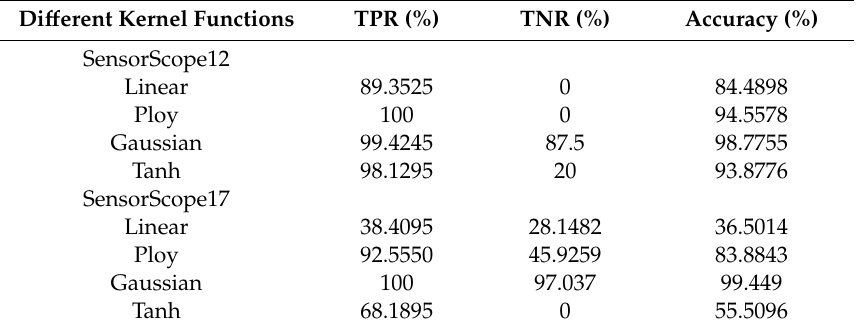
Table 3. Comparison among di ff erent kernel functions. TNR: true negative rate; TPR: true positive